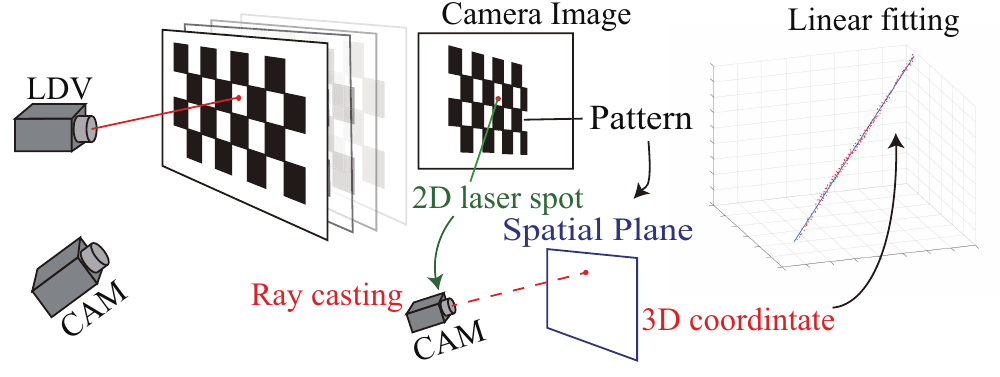
Figure 2. Geometric-only calibration